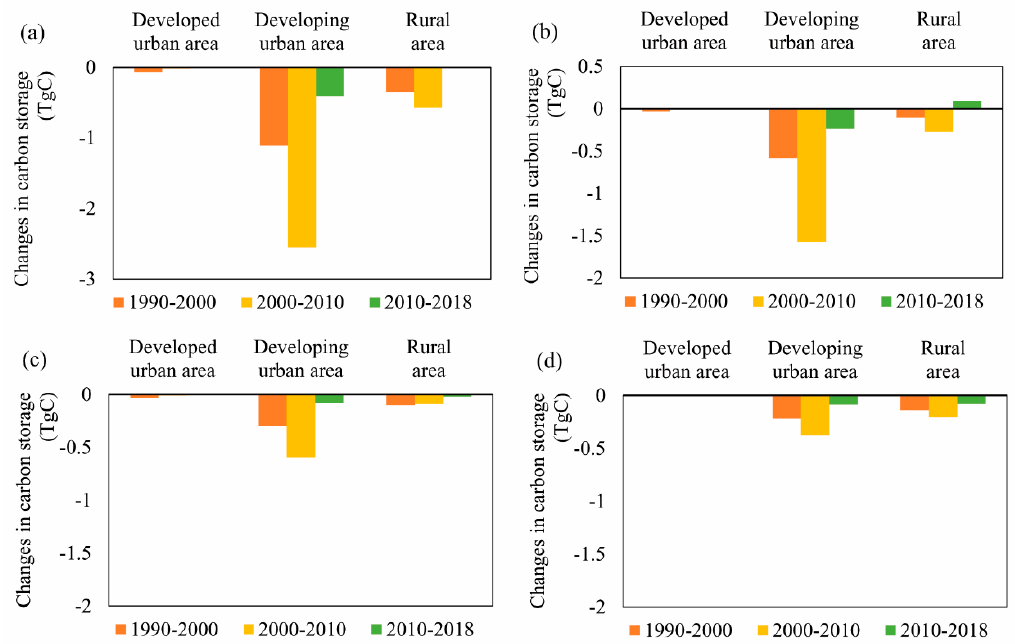
Figure 6. Carbon storage changes in areas with different urbanization levels for ( a ) the whole study area, ( b ) Suzhou, ( c ) Wuxi, and ( d ) Changzhou.